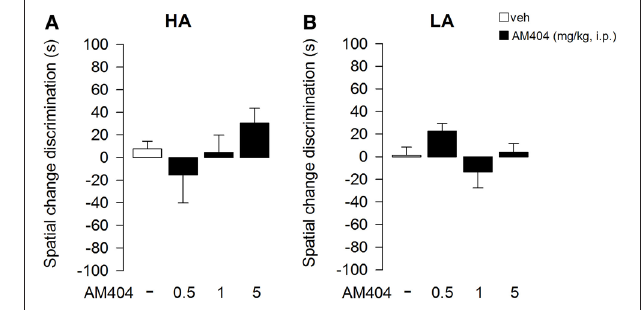
FIGURE 6 | Effects of AM404 administration on object investigation in rats exposed to high arousal (HA) or low arousal (LA) conditions. Total investigation time of all objects by rats exposed to HA (A) or LA (B) conditions through sessions 2–6. * P < 0 . 05. Data are expressed as mean ± SEM. (HA: veh n = 10, 0.5mg/kg n = 11, 1mg/kg n = 10, 5mg/kg n = 9; LA: veh n = 15, 0.5mg/kg n = 12, 1mg/kg n = 14, 5mg/kg n = 13).